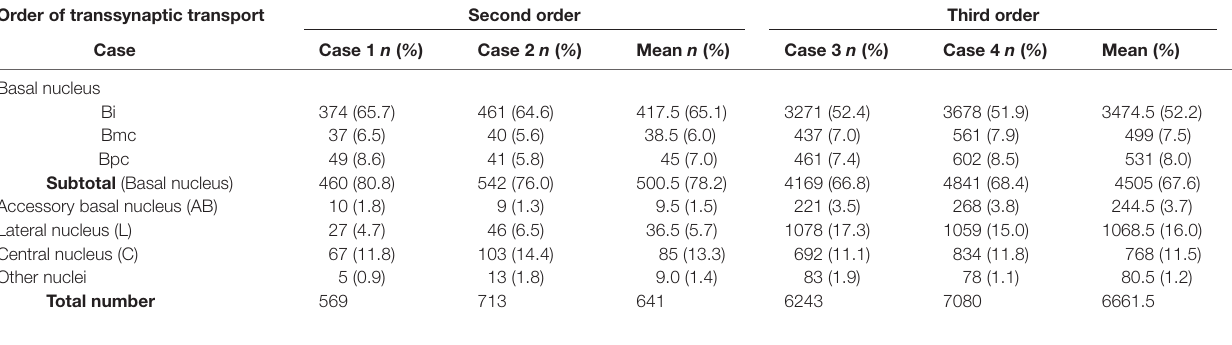
TABLE 2 | Distributions of the number ( n ) and ratio ( % ) of labeled neurons in the amygdalar subnuclei after rabies injections into PMv. Order of transsynaptic